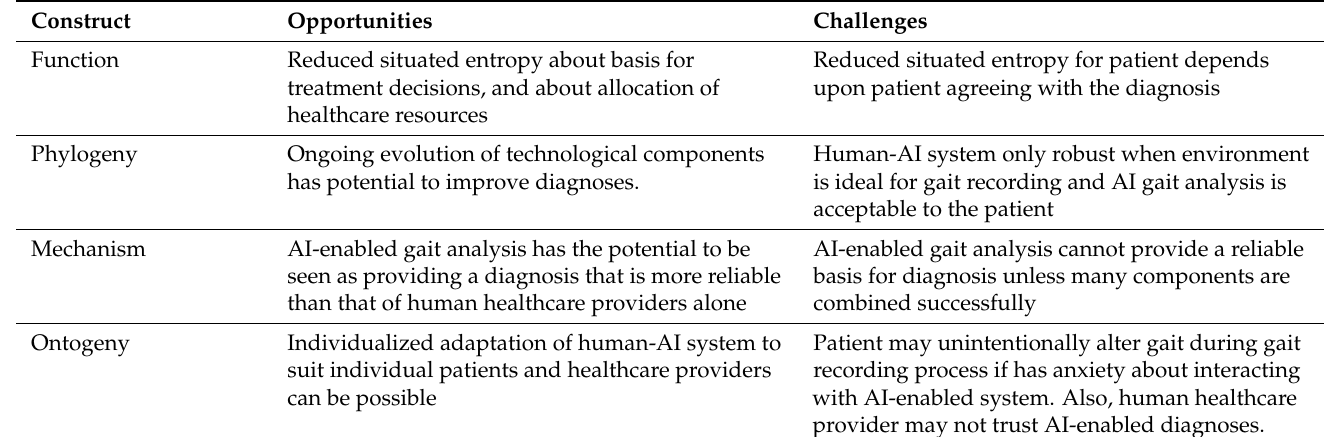
Table 6. Diagnostic support example of opportunities and challenges for behavioral ethics in human- AI